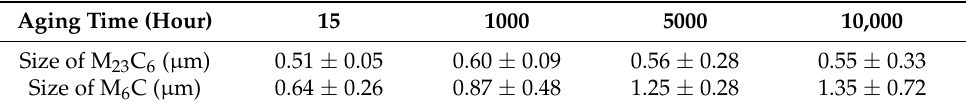
( b ) Figure 11. Grain boundary precipitates after SA: ( a ) TEM micrograph and ( b ) TEM-EDS line-scan cross the boundary.